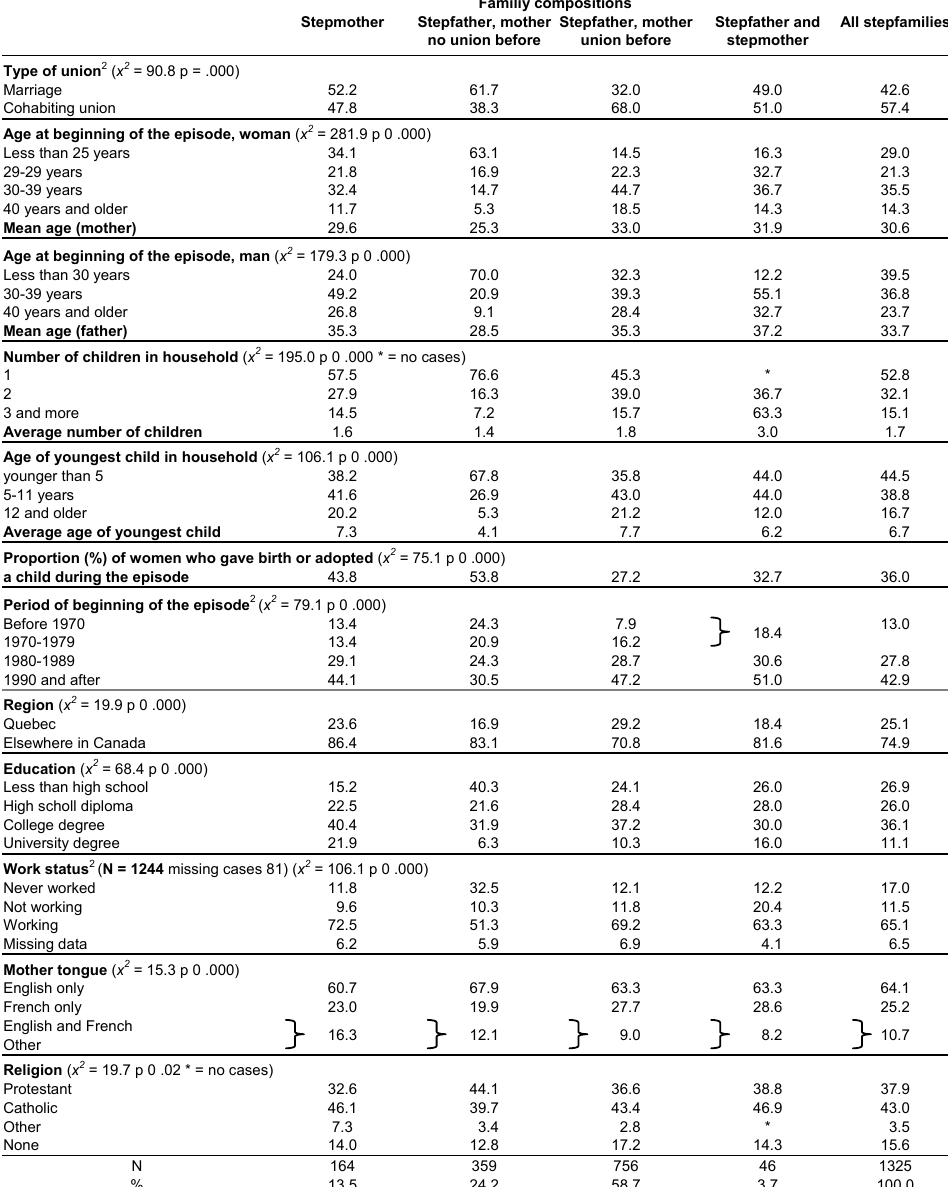
Table 1: Descriptive statistics (% or means) 1 for covariates used in the analysis of separation among first stepfamilies episodes, according to family composition Familiy compositions Stepmother Stepfather, mother Stepfather, mother Stepfather and All stepfamilies no union before union before stepmother Type of union 2 ( x 2 = 90.8 p = .000) Marriage